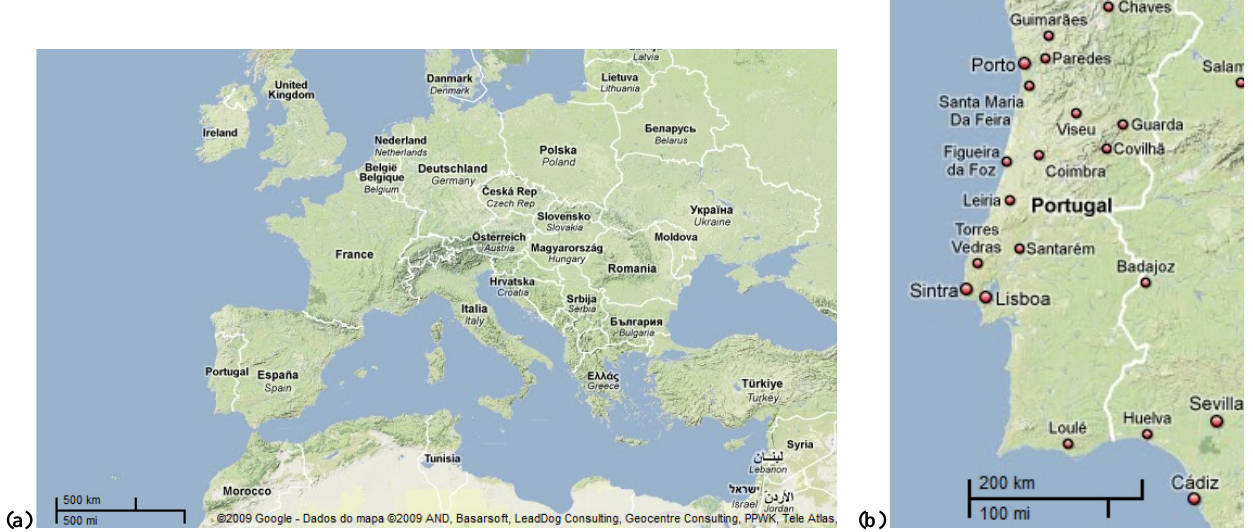
Fig. 1. (a) Map of Europe and North Africa, retrieved from Google Maps website http://maps.google.pt/, and (b) a zoom of Portugal for a better visualization of the country orography.